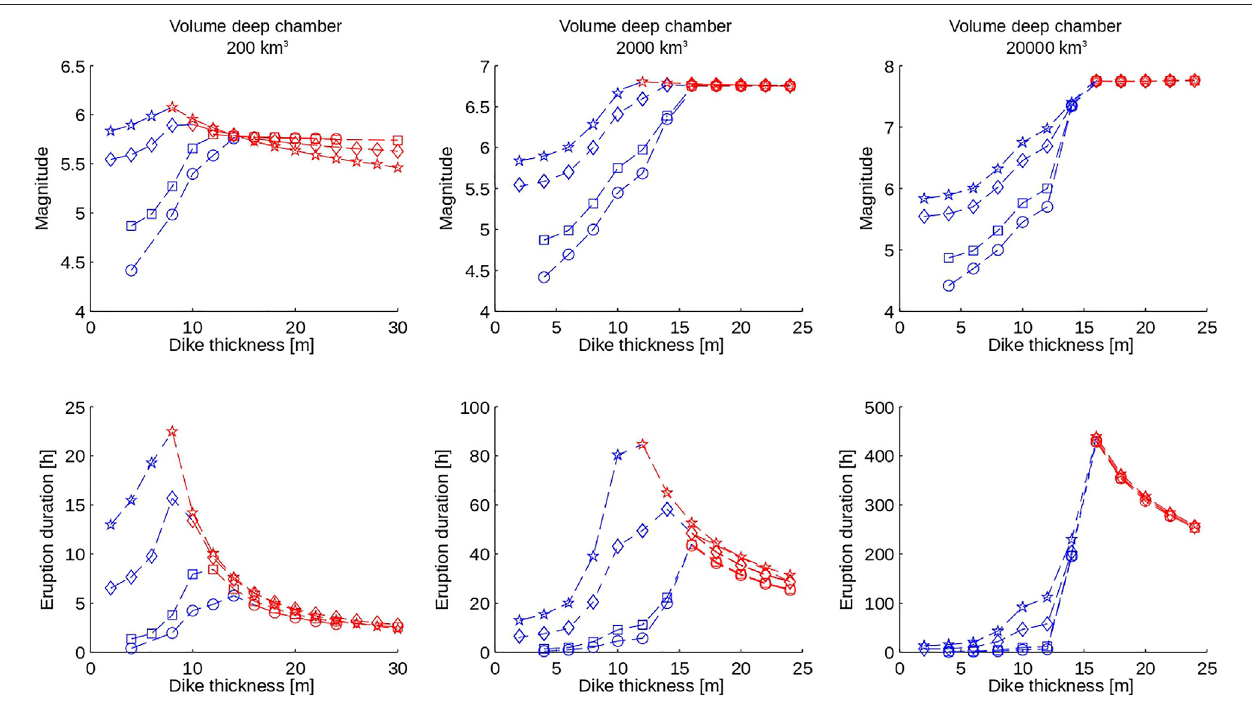
FIGURE8| Roleofdeepinterconnections.Calculatederuptionmagnitude(toppanel)andduration(bottompanel)asafunctionofdykethickness,fordifferentdeep chamber volumes and other conditions as in Figure 7 . The different symbols refer to different shallow chamber volumes: circles (cid:2) 1 . 5km 3 ; squares (cid:2) 3km 3 ; diamonds (cid:2) 15km 3 ; stars (cid:2) 30km 3 . Symbol colors as in Figure 1 : blue and red indicate eruption closure by shallow or deep chamber collapse, respectively.